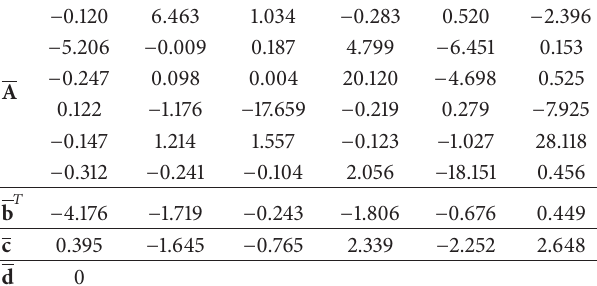
Table 13: Identification result for Case 3 .